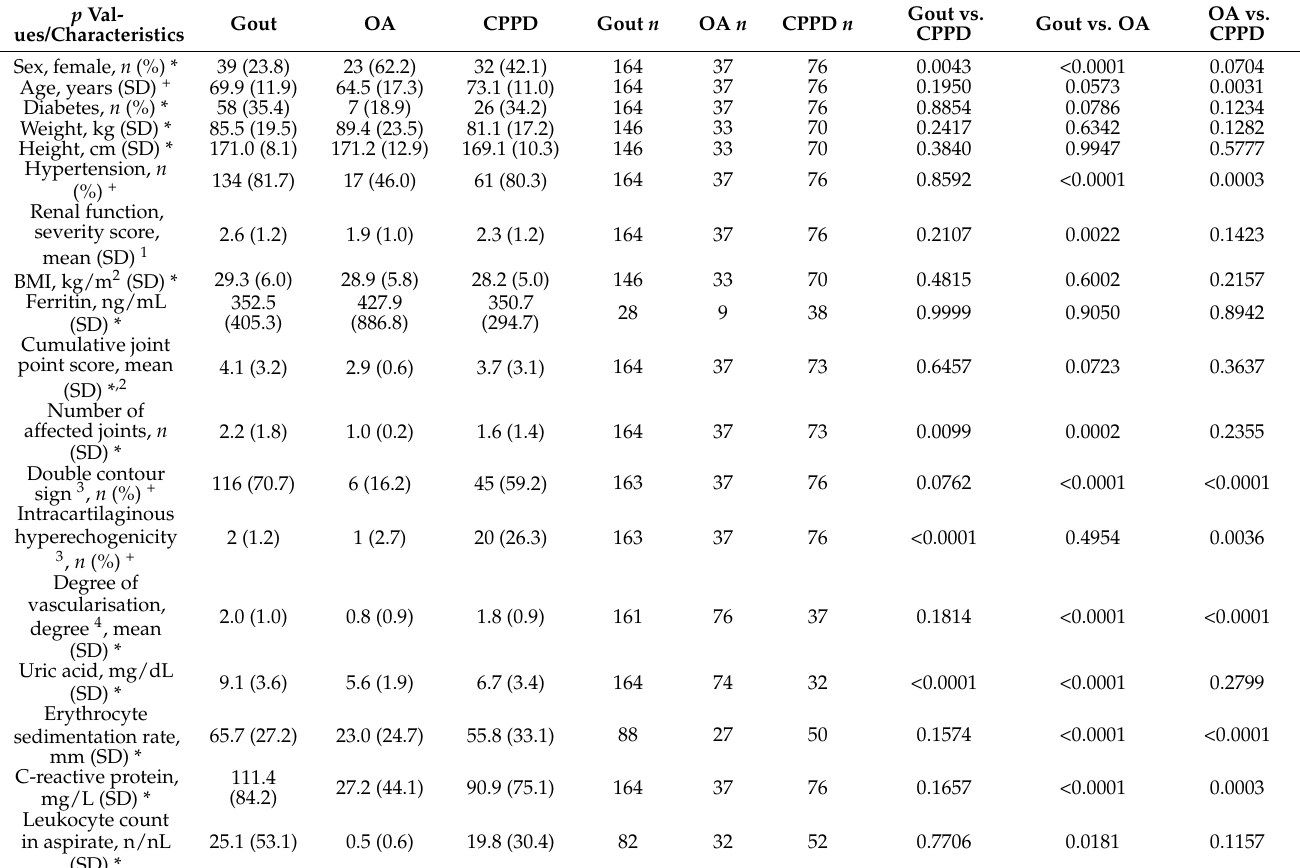
Table 3. Results of comparative statistical analysis of commonly derived clinical, laboratory, and imaging